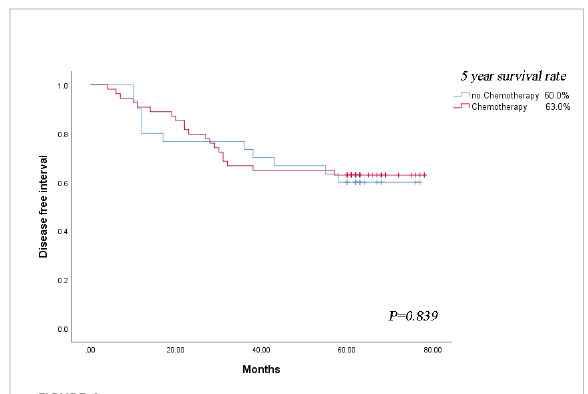
FIGURE 4 Survival outcomes regarding disease-free survival based on the strategy of adjuvant